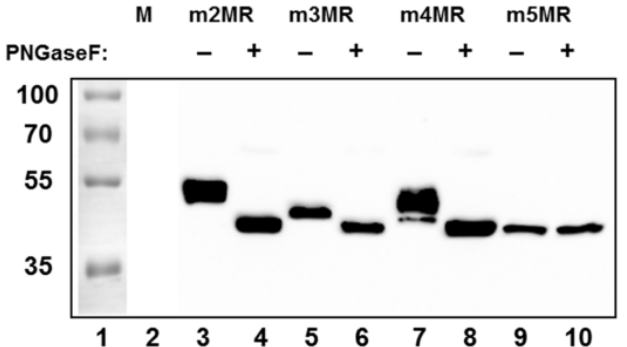
Figure 2. Glycosylation status and secretion of NS1 protein from the mutant virus-infected cells. Cells in 6-well plates were mock-infected (M) or infected with the mutant viruses (shown on top) at an MOI (multiplicity of infection) of 1. Cell culture supernatants were collected at 48 dpi, and proteins from an equal volume of supernatants were concentrated by acetone precipitation, digested with PNGase F ( + ), or left undigested ( − ) and analyzed by Western blotting using anti-NS1 antibody. Relative migration of molecular mass markers (in kDa) is shown on the left.